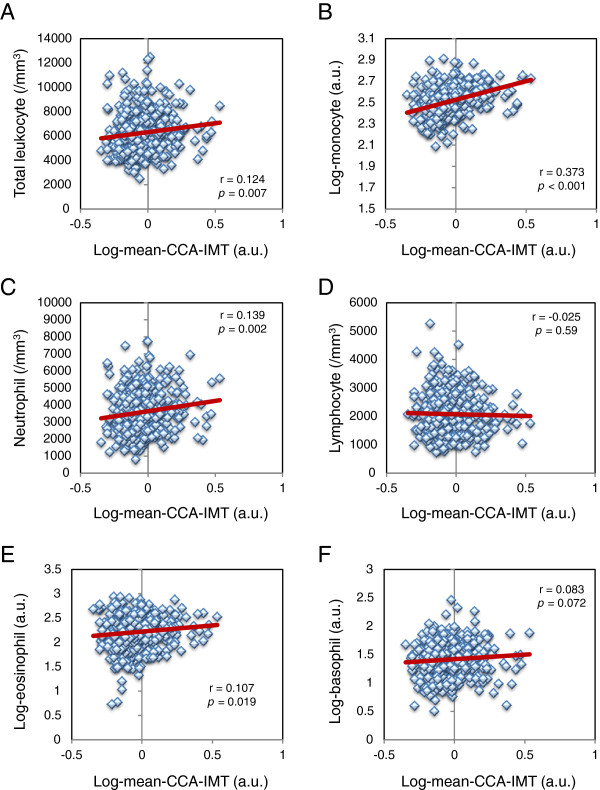
Association of leukocyte subset counts with mean-CCA-IMT in patients with type 2 diabetes. A, total leukocyte count; B, monocyte count; C, neutrophil count; D, lymphocyte count; E, eosinophil count; F, basophil count. Since mean-CCA-IMT, monocyte count, eosinophil count and basophil count showed skewed distribution, data were logarithmically transformed before the analysis. a.u., arbitrary unit.